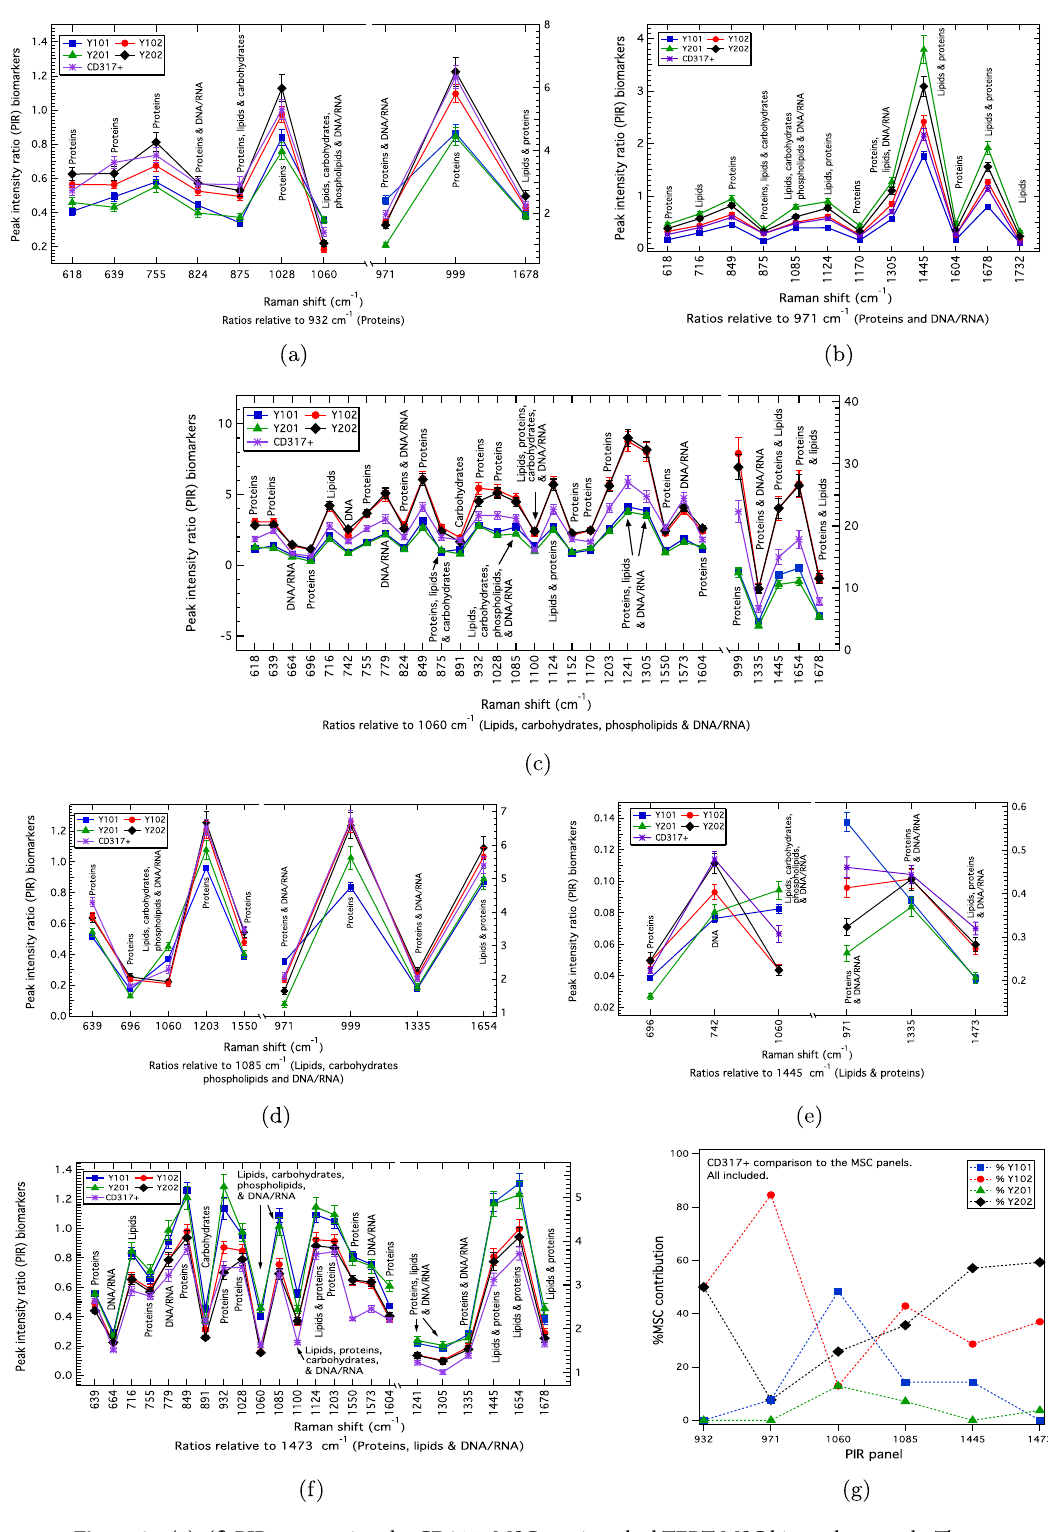
Figure 3. ( a )–( f ) PIRs comparing the CD317+MSCs against the hTERT MSC biomarker panels. The uncertainties correspond to the propagated standard error of the mean. The CD317+MSCs show a close match to the Y102/Y202 cell-lines, which aligns with them being biologically-similar as per Ref. 14 . ( g ) KNN- classification across all of the comparison panels confirms a total Y102/Y202 contribution of 82% (Table 1). For − 1 the 971 cm panel ( b ), which stratifies cell-type, the KNN results in ( g ) shows the CD317+MSCs to be most closely matched at 85% to